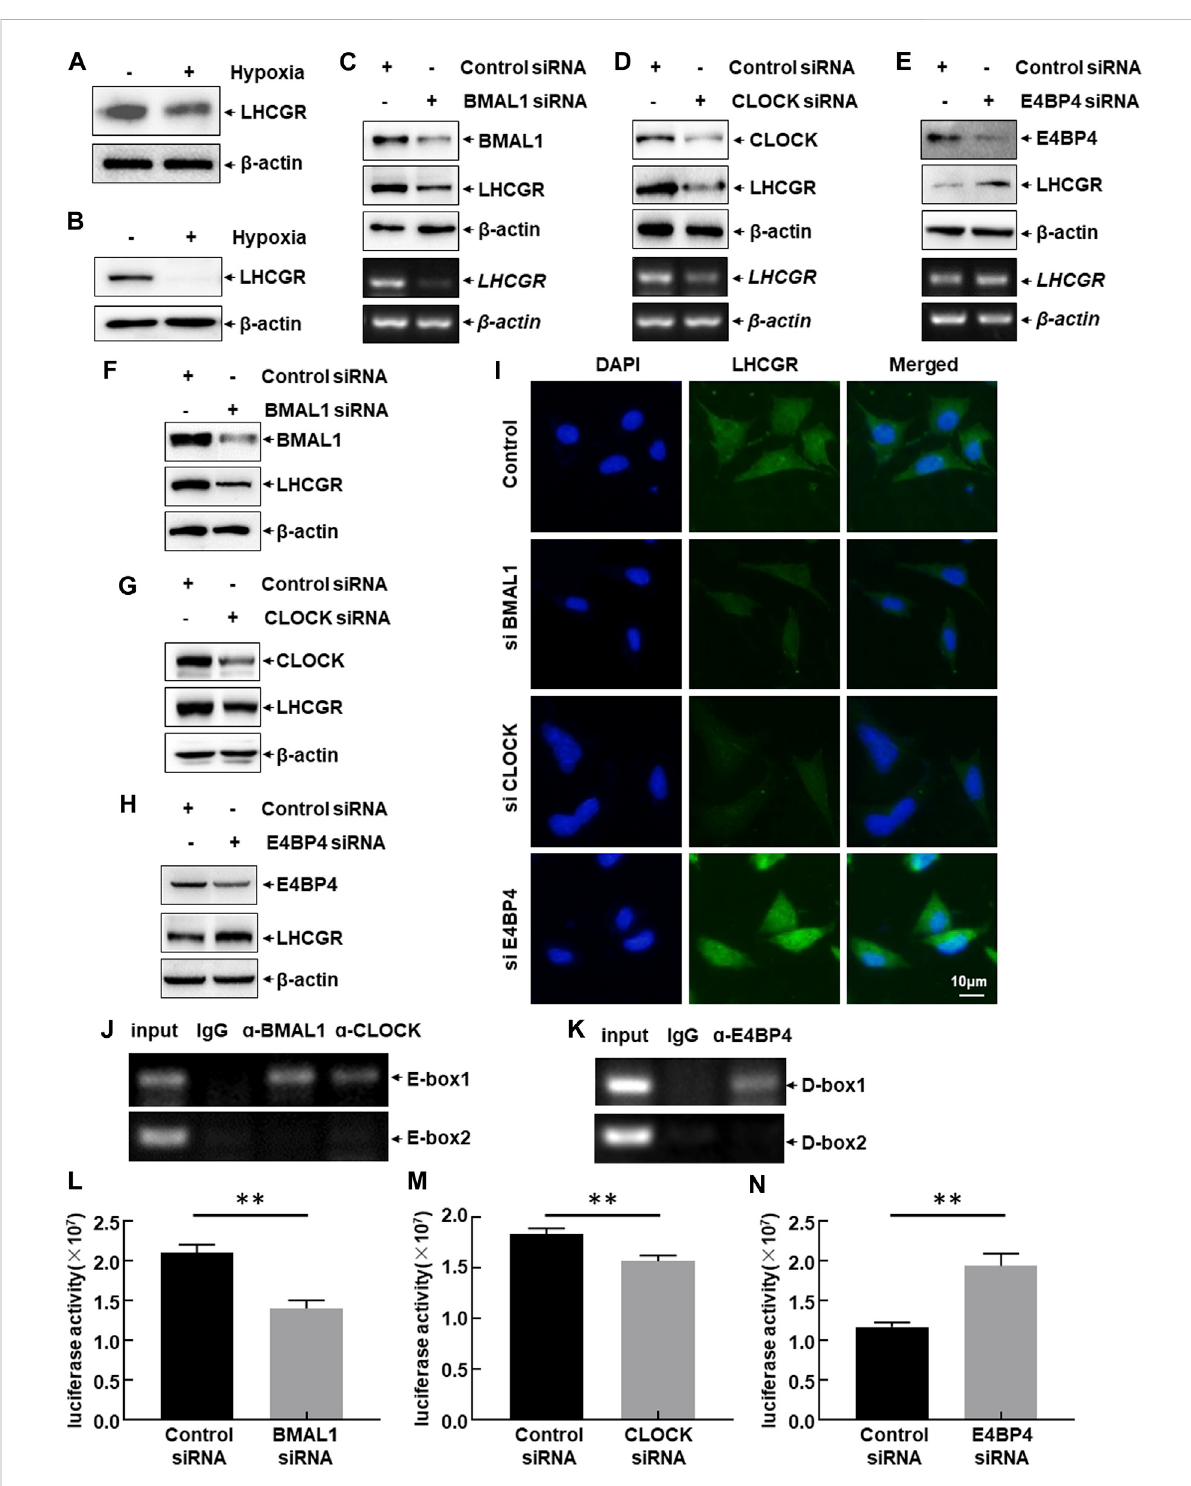
FIGURE 4 CLOCK, BMAL1, and E4BP4 were involved in LHCGR transcription in the granulosa cells. (A) Primary granulosa cells (GCs) were prepared and culturedundernormoxic(21%O 2 )orhypoxic(1%O 2 )conditionsfor6 h.CellswerethencollectedtodetectLHCGRexpression. (B) KK1cellscultured under the same conditions and LHCGR levels detected. (C – E) Primary GCs were transfected with CLOCK, BMAL1, E4BP4 siRNA, or control siRNA. Changes in LHCGR mRNA and protein levels were detected. KK1 cells were transfected as described for the primary GCs, and LHCGR levels were detected using Western blot (F – H) and in situ immuno fl uorescence staining (I) . (J – K) ChIP assays were performed in KK1 cells to detect the bindingsiteofCLOCK:BMAL1heterodimer andE4BP4withinthemouseLHCGRpromoterregion. (L – N) KK1cellsweretransfectedwiththeLHCGR promoter-driven luciferase reporter in combination with siRNA targeting CLOCK, BMAL1 or E4BP4 or control siRNAs. Luciferase activity was detected at 36 h after transfection (** p <